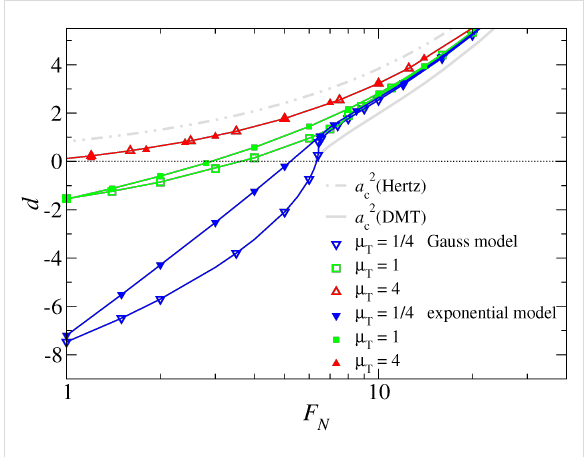
Figure 18: Displacement d as a function of normal force F N in the vicinity of the spontaneous wetting force F sw . Symbols reflect numeri- cal results. The lines, which connect many data points not explicitly shown, are drawn to guide the eye. The two thick grey lines reflect the square of the contact radius in the Hertz and DMT approximation, re- spectively. Color coding: μ T = 4 (red), μ T = 1 (green), and μ T = 1/4 (blue).